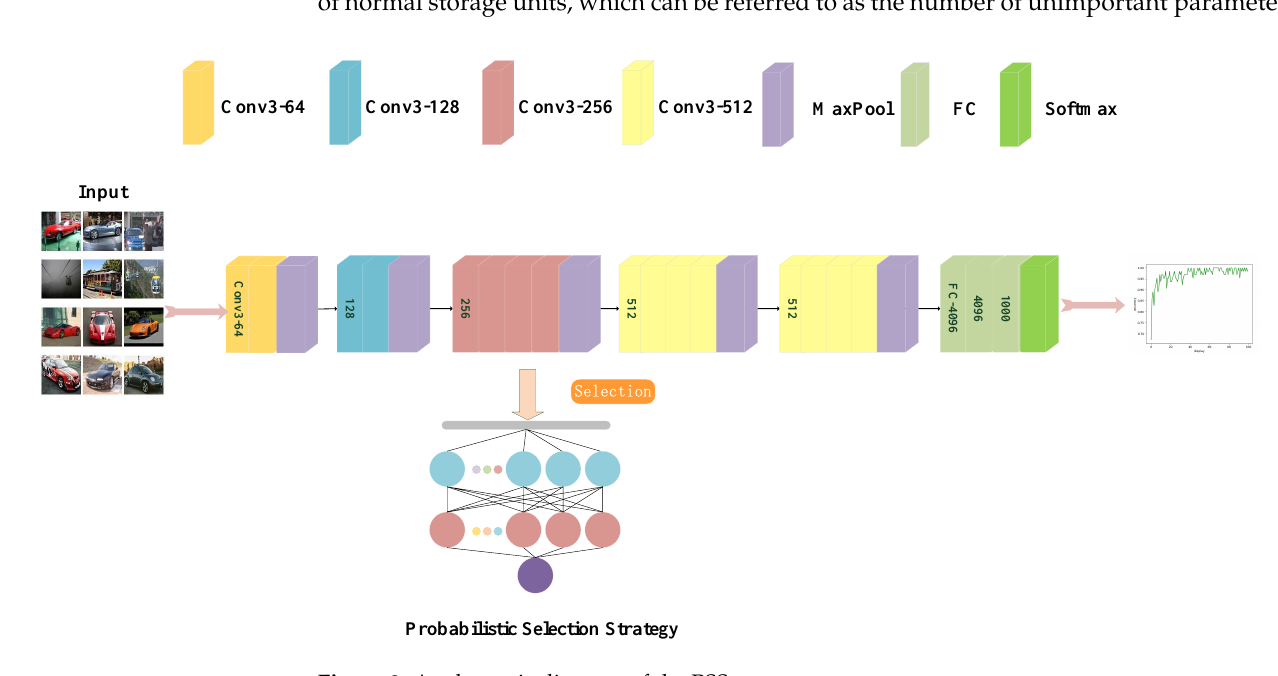
Figure 2. A schematic diagram of the PSS.